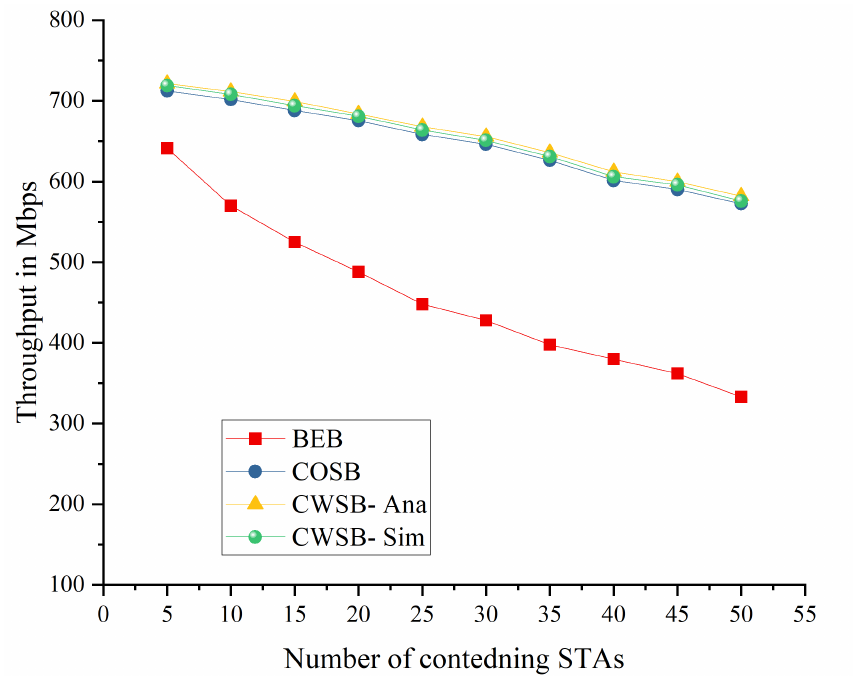
Figure 13. Throughput comparison of BEB, COSB and CWSB for an indoor residential scenario. Per-station throughput evaluation metrics are suggested by 11ax TG, such as (i) at the 5th percentile (the minimum throughput of stations measured at the cell edge), (ii) at